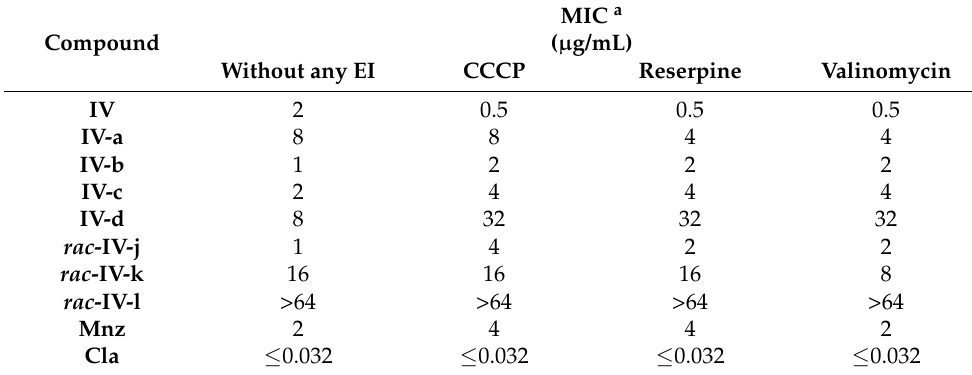
Figure 5. Multiple sequence alignment of flavodoxins from C. jejuni , H. muridarum , H. bilis , H. hepaticus , H. pylori , H. suis , H. bizzozeronii , H. felis , H. heilmannii and H. ailurogastricus . The alignment has been performed with Clustal Omega. [42] In all sequences, the amino acid residue at position 55 (according to Hp -Fld numeration) is highlighted in red. As seen, the flavodoxins from H. pylori , H. suis , H. bizzozeronii , H. felis , H. heilmannii and H. ailurogastricus exhibit an alanine at this position, whereas a tyrosine is shown in that from H. hepaticus and a tryptophan is exhibited by those from C. jejuni , H. muridarum and H. bilis . Asterisks (*) highlight positions with a fully conserved residue; colons (:) indicate positions of residues with high similarity; dots (.) indicate positions with residues possessing weak similarity. Table 3. In vitro activity of IV-related compounds alone and in combination with CCCP, reserpine and valinomycin against H. pylori strain ATCC